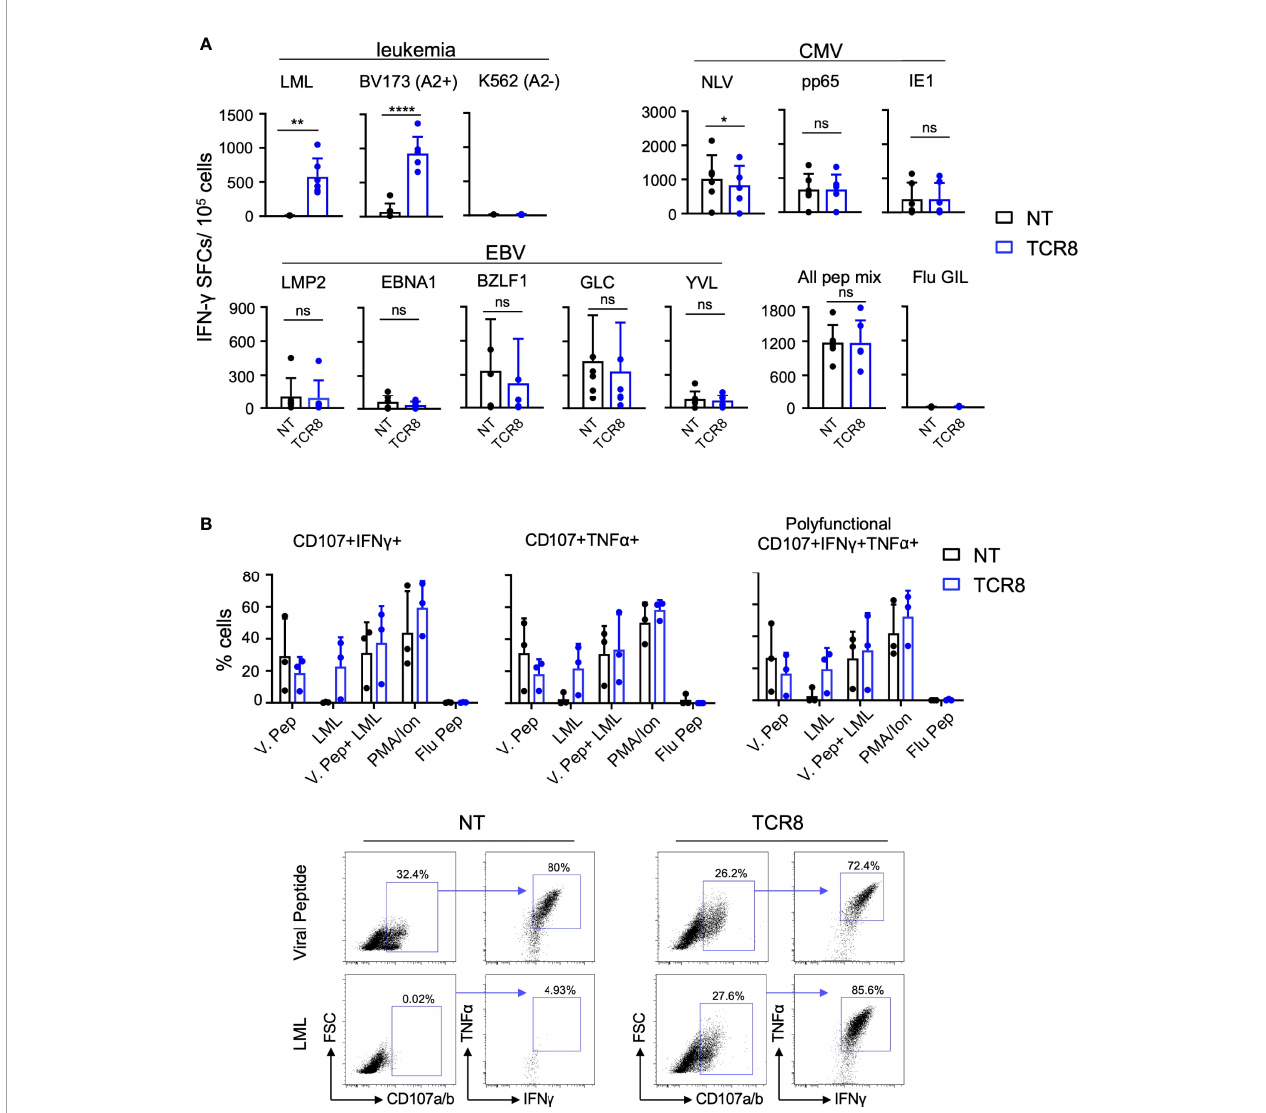
FIGURE 3 | TCR8+ VSTs are multi-antigen speci fi c for survivin and viral (CMV and EBV) antigens. (A) NT or TCR8+ VSTs after S1 were stimulated with viral (CMV and EBV) pepmixes/peptides, survivin peptide, or leukemia cell lines (BV173: HLA-A2*02:01+survivin+ or K562: HLA-A2-) for 24 h and IFN- g spot forming cells (SFC) were measured by ELISPOT, n=6, mean ± SD: NT vs TCR8+, LML peptide: **p=0.003, BV173: ****p<0.0001, NLV peptide: *p=0.035, pp65, IE1, LMP2, BZLF, EBNA1, GLC peptide, YVL peptide: mean ± SD, p=ns, n=6. (B) NT or TCR8+ VSTs were stimulated with viral pepmixes, LML peptide, viral pepmixes plus LML peptide, PMA/Ionomycin (25 ng/ml) or irrelevant in fl uenza GIL peptide (negative control) for 4 h and stained for degranulation (CD107a/b) and intracellular IFN- g and TNF- a followed by FACS analysis. The percentage of cells expressing CD107a/b+/IFN g + (top left), CD107a/b+/TNF a + (top middle) and (CD107a/b+/IFN g +/TNF a + (polyfunctional, top right) are shown. Dots, mean ± SD, n=3 donors. Representative FACS plots are shown on the bottom (gated on total live cells, then gated on CD107a/b+ cells) for NT (left) and TCR8 (right). ns, not signi fi